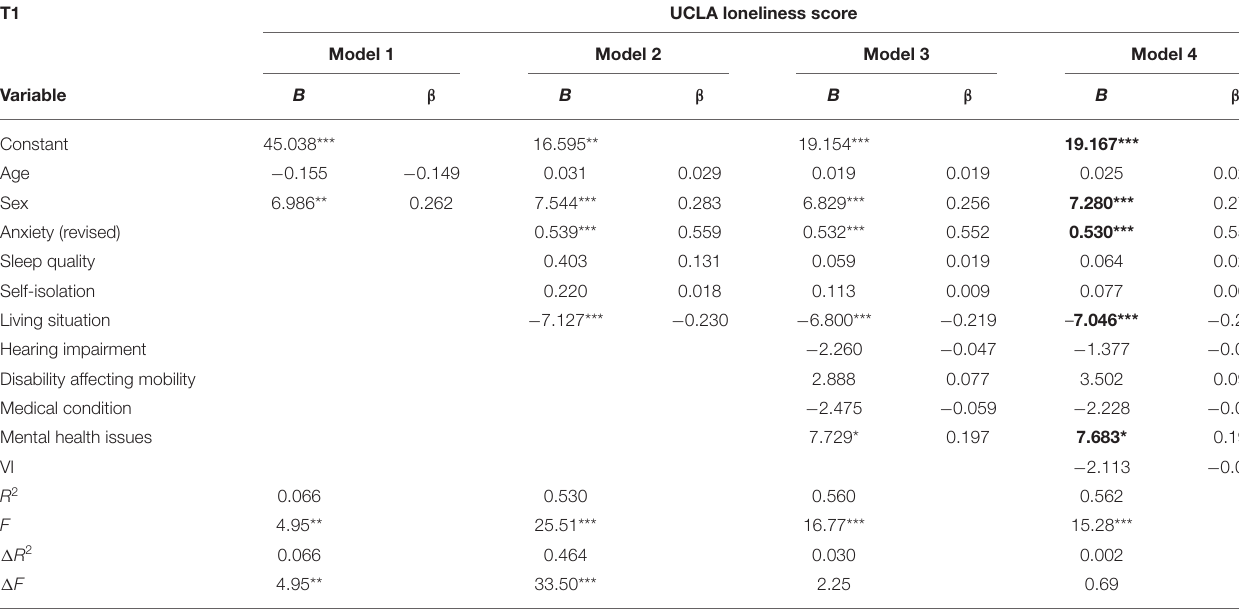
TABLE 3 | Hierarchical multiple regression for UCLA loneliness at